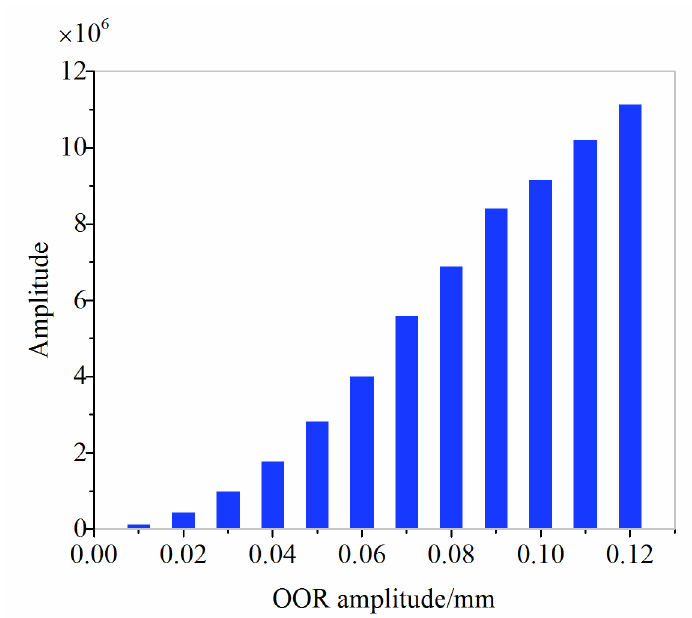
Figure 10. Peak power amplitude of axle-box acceleration due to 24th-order polygonal wheels as a function of OOR amplitude.